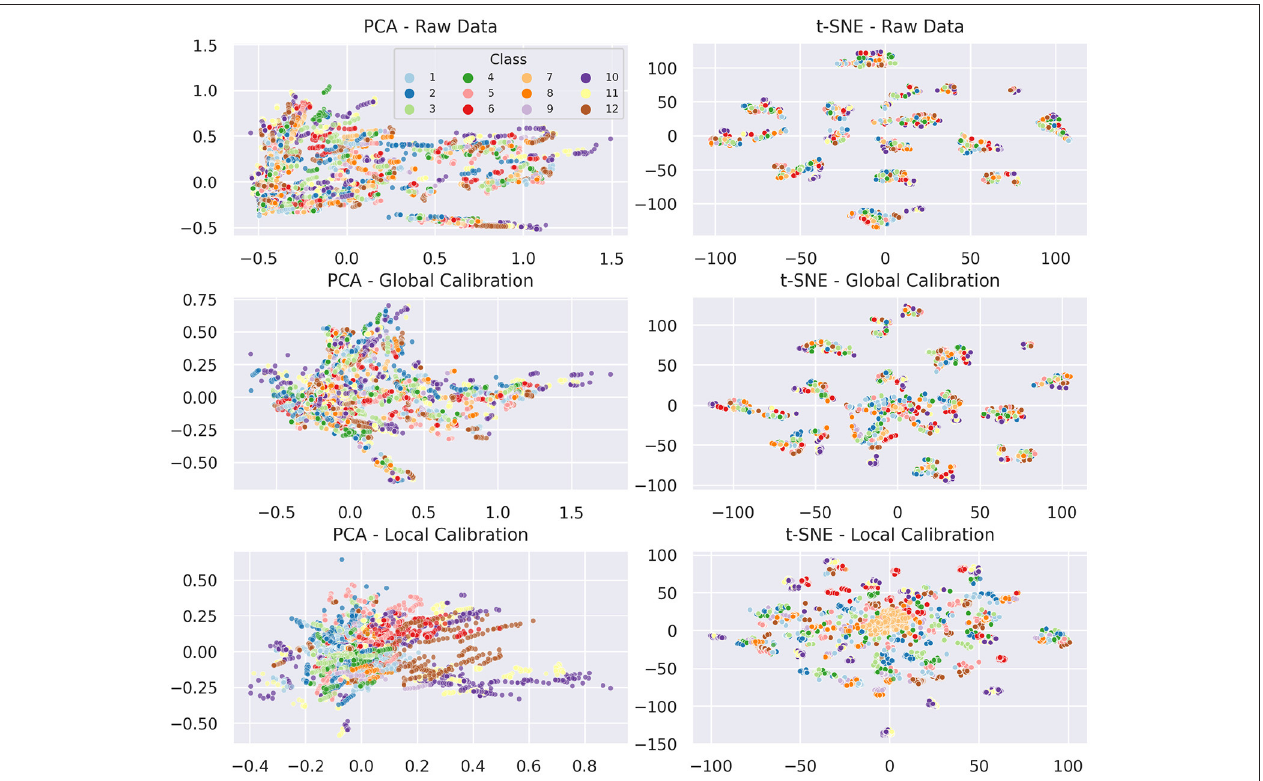
FIGURE 11 | Effects of calibration on PCA and t-SNE (perplexity = 90). Data points are colored by class label. For all projections, data from subject F was omitted for a better comparison between local and global